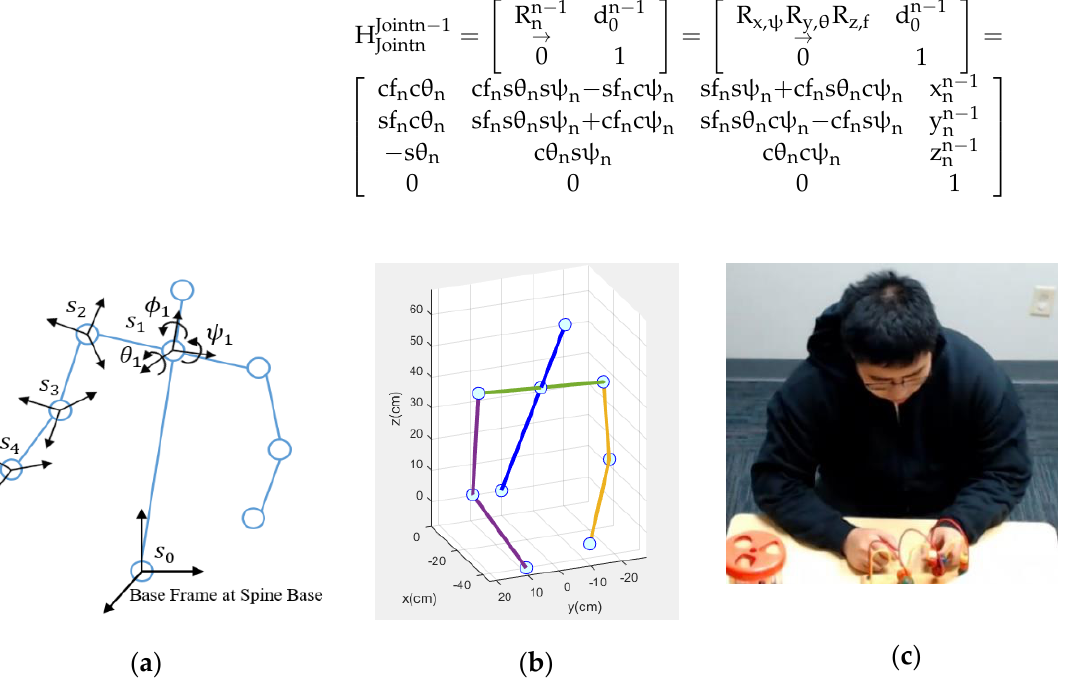
Figure 5. ( a ) Forward Kinematics of WINGS; ( b ) WINGS Skeleton Visualization; and ( c ) User Gesture.